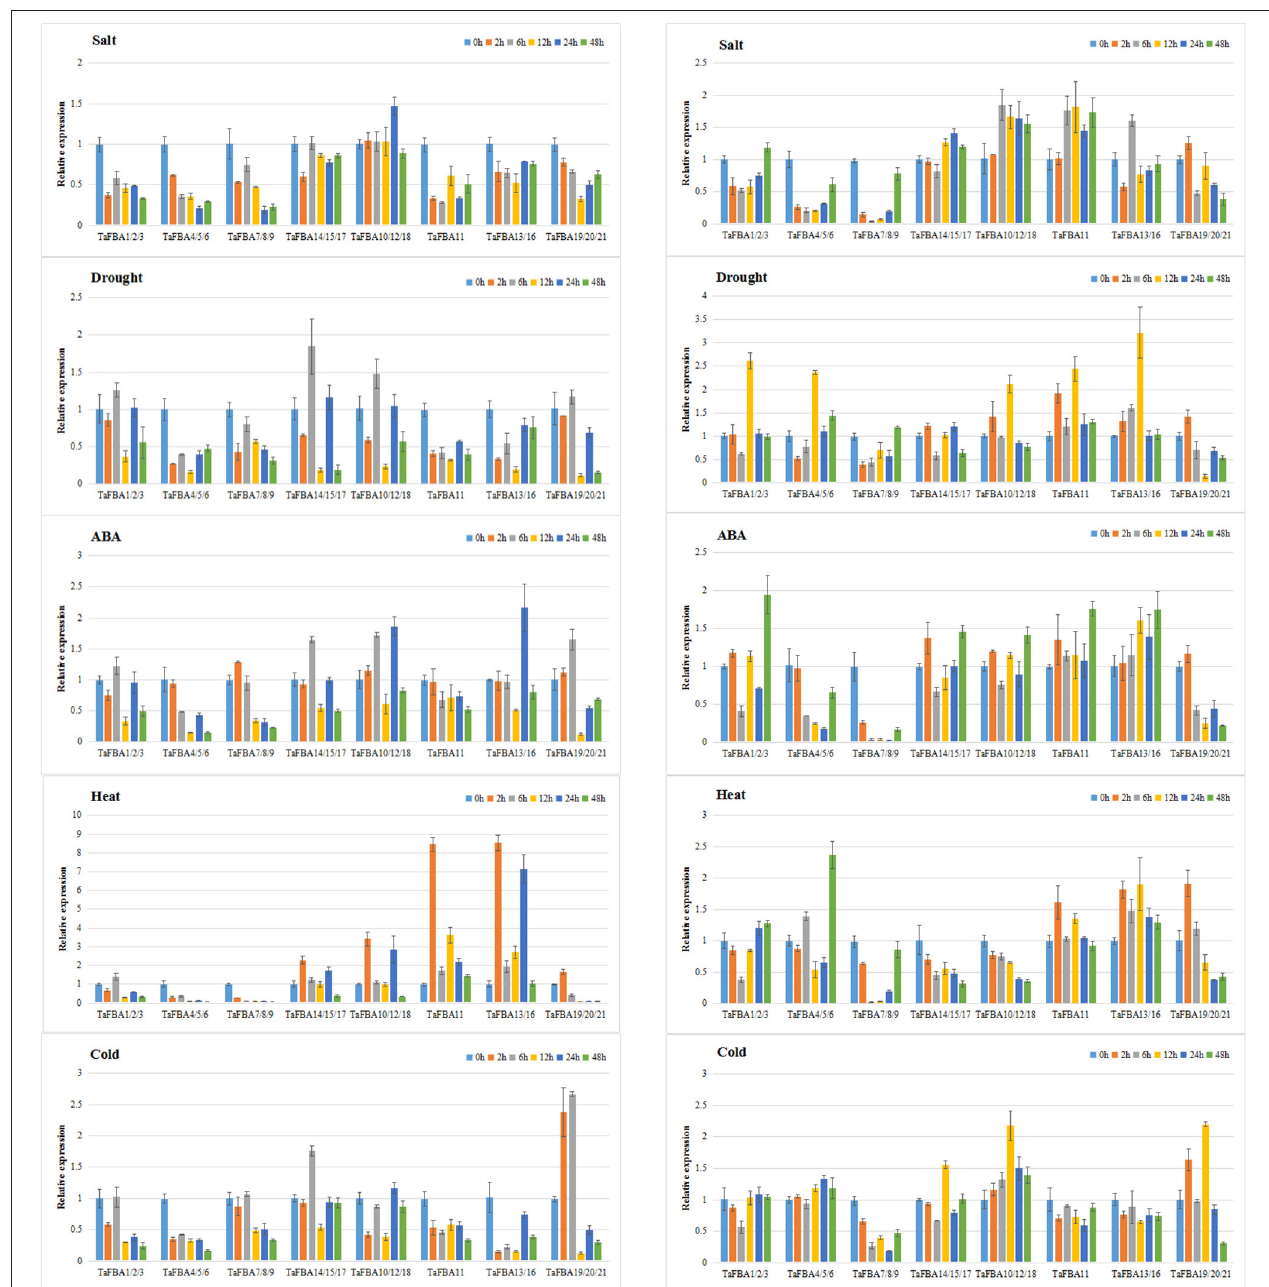
FIGURE 8 | Expression profiles of TaFBA genes in shoots (A) and roots (B) under abiotic stresses. The data came from qRT-PCR analysis with 2 − 11 Ct method. For each of the TaFBA genes, the relative expression value under normal condition was defined as